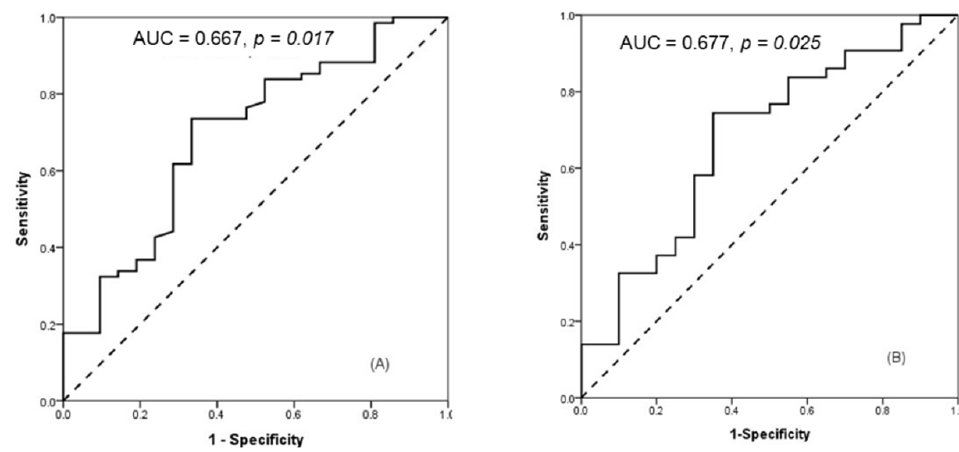
Figure 3. Receiver operating curve for posterior cervical angle ( A ) and ( B ) in primiparity.